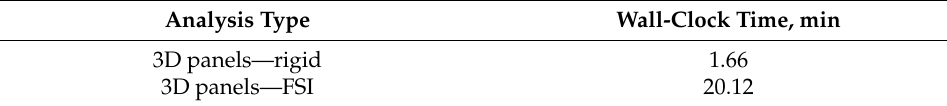
Table 9. Wall-clock time comparison between rigid and FSI aerodynamics.